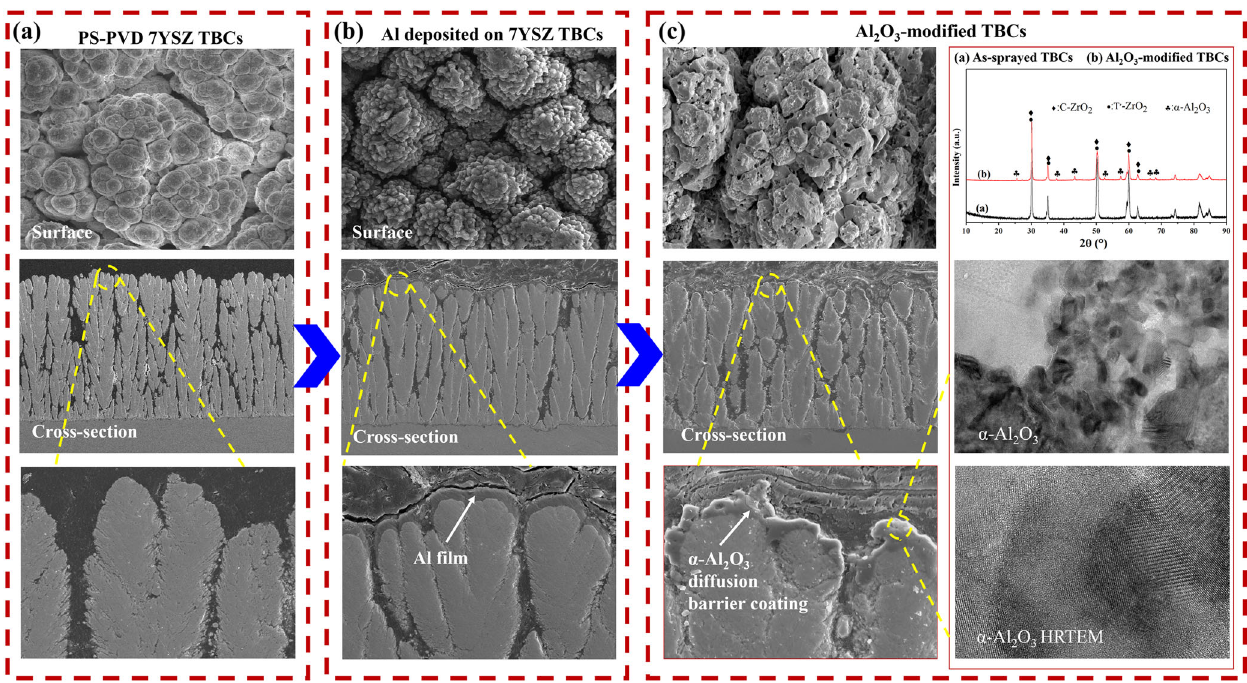
Fig. 3 Microstructural evolution of PS-PVD 7YSZ TBCs during the Al 2 O 3 -modi fi cation process. a Surface and cross-section of as-sprayed TBCs. b Surface and cross-section of Al-deposited TBCs. c Surface and cross-section of Al 2 O 3 -modi fi ed TBCs, with XRD and TEM analysis of the Al 2 O 3 -modi fi ed layer.